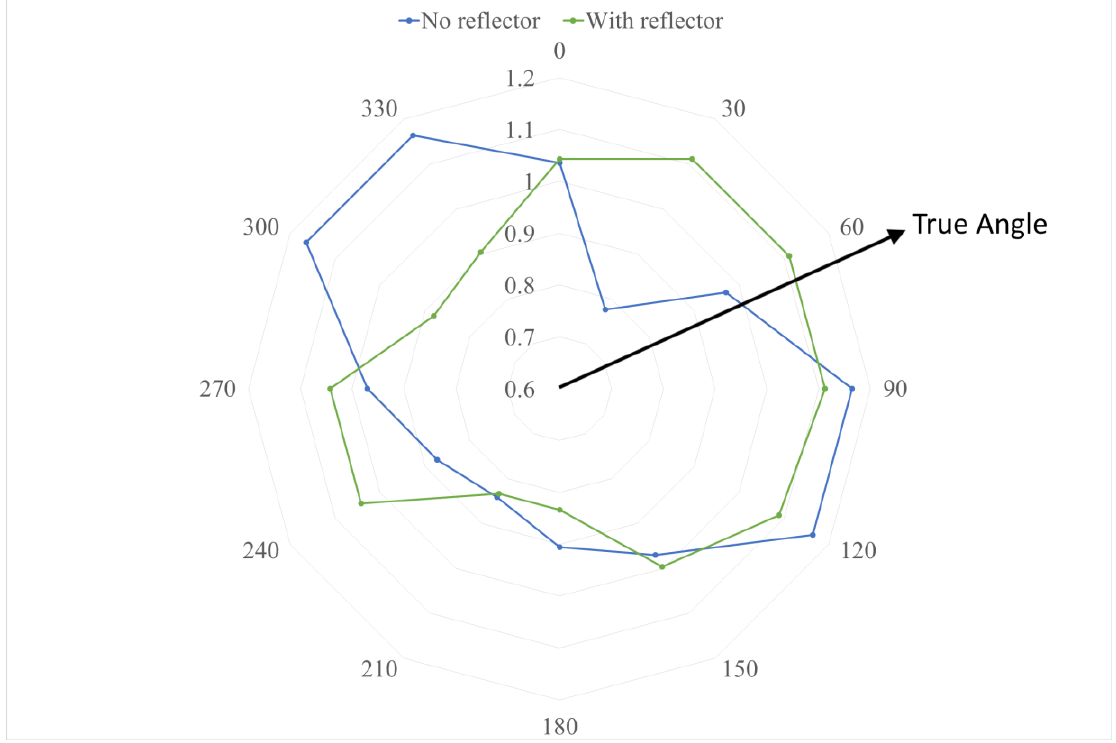
Figure 6. Comparative analysis of the Received Signal Strength (RSS) for an antenna with and without a reflector. The RSS (normalised as a ratio of the mean value) shows improved directionality, with the strongest RSS in the direction of the true angle when using a parabolic reflector.